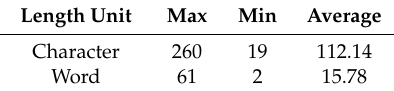
Table 26. Xhosa corpora statistics.